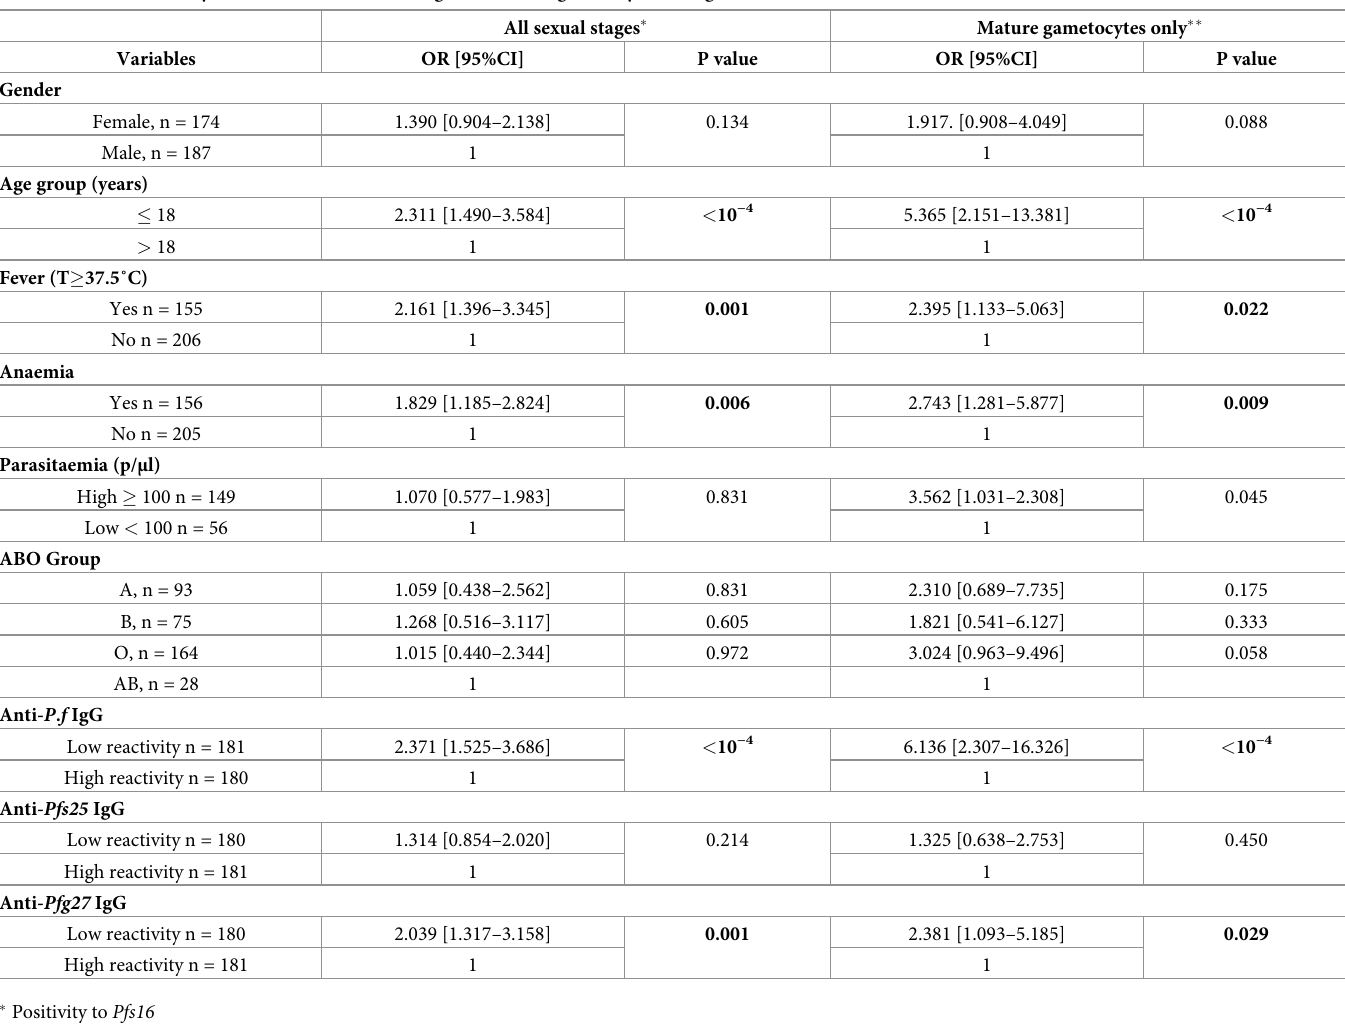
Table 3. Univariate analyses of risk factors for all stage and mature gametocyte